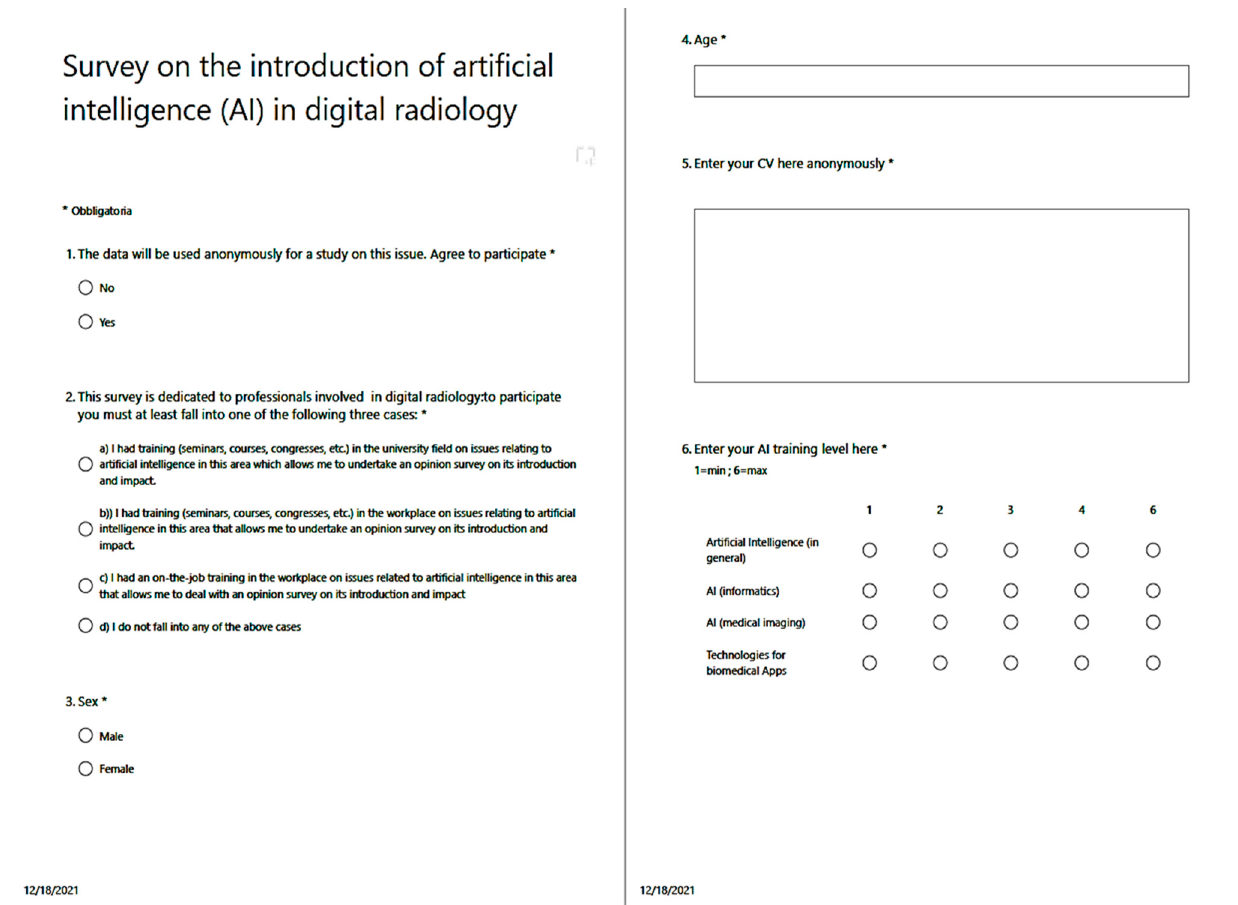
Figure A1. An example of the survey (first print screen).